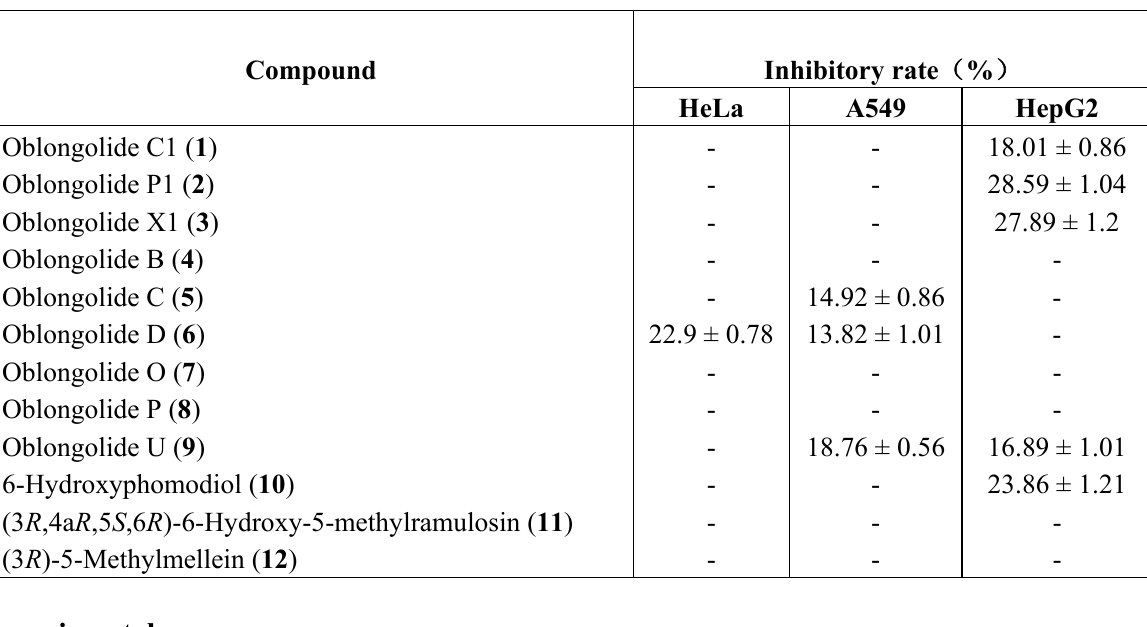
Table 4. Biological Activities of Compounds 1 - 12